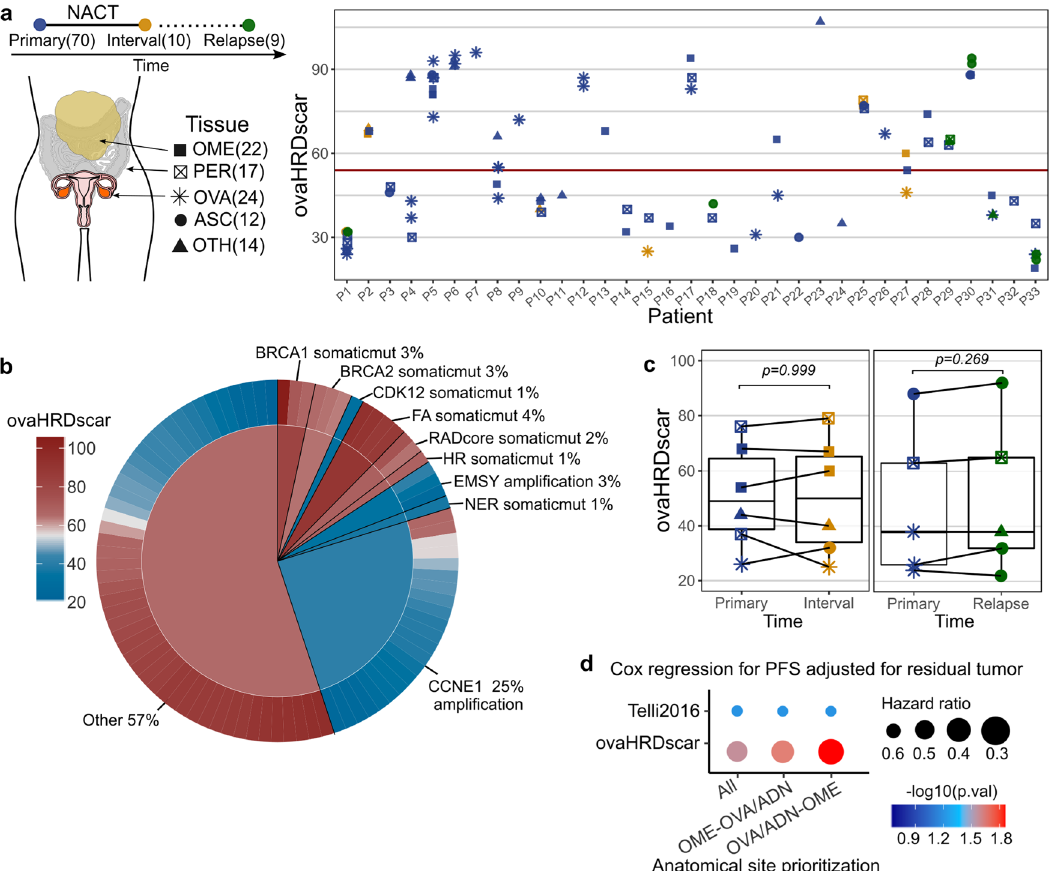
Fig. 4 Intra-patient spatiotemporal variation of ovaHRDscar levels in 98 prospective HGSC samples. a Overview of the samples and their ovaHRDscar levels per patient in a prospective cohort (DECIDER). The tumor samples were collected at three different treatment phases and from different anatomical sites; the corresponding number of samples are displayed in parentheses. b Levels of ovaHRDscar in samples harboring different genetic or epigenetic alterations associated with HRD. The colors correspond to the ovaHRDscar levels, in the outer ring of the pie chart every bar represents a sample carrying the corresponding alteration, and average values for the genetic groups are displayed in the center of the pie chart. c ovaHRDscar values between paired samples for each patient (connected dots) did not change (Wilcoxon test) between the samples collected at different treatment phases. For the box plots, the black horizontal lines represent the sample medians, the boxes extend from fi rst to third quartile and whiskers indicate the values at 1.5 times the interquartile range. d Comparison of anatomical site prioritizations using Cox regression models for PFS using the Telli2016 or the ovaHRDscar algorithms. The size of the dot represents the HR and color of the dot represents the p -value. The HR-status for each patient is shown assessed using three anatomical sample